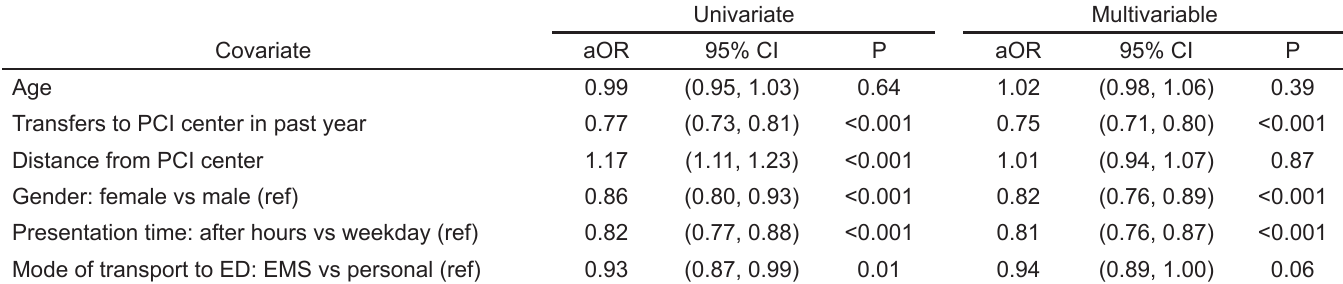
Table 3. Results from the generalized linear regression models investigating the association of the electrocardiogram-to-emergency medical services activation interval to a priori selected